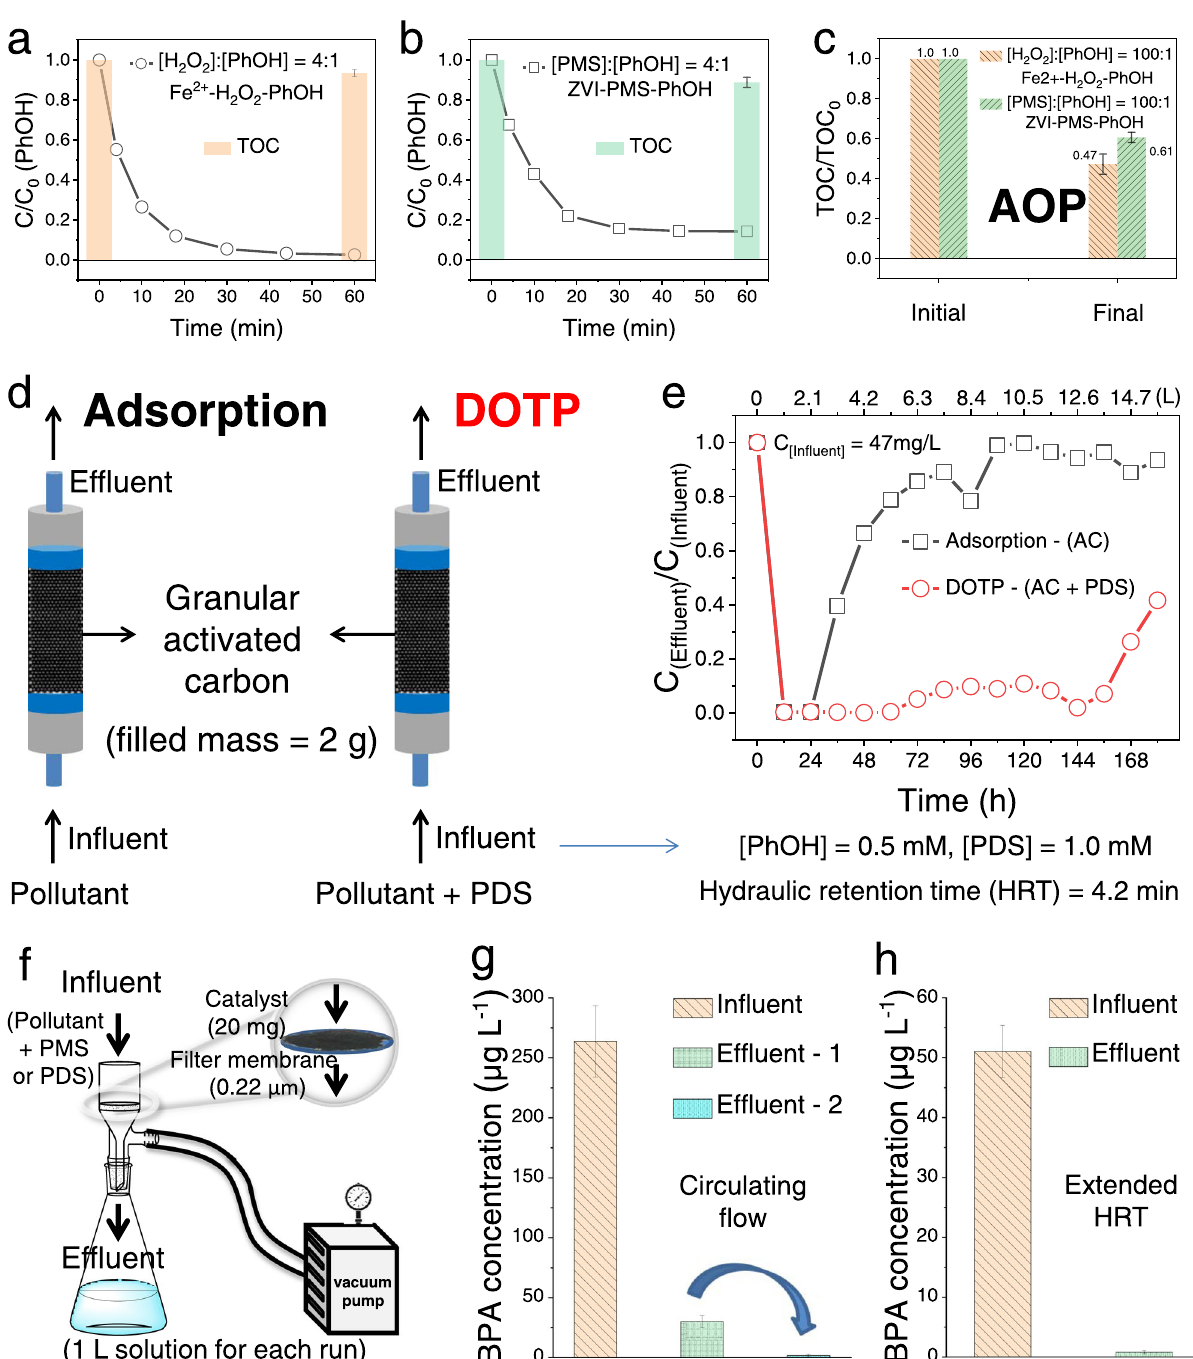
Fig. 7 Evaluation of the practical application of DOTP, AOP, and adsorption processes. a , b Pollutant removal and TOC elimination in the typical Fe 2 + / H 2 O 2 ( a ) and ZVI/PMS ( b ) AOP systems, with oxidants to pollutants dosage ratios of 4:1. c Final removal of TOC in the two typical AOP systems at an oxidant dosage 100 times the molar concentration of the pollutant. d , e Water puri fi cation effects re fl ected by the continuous- fl ow operation of DOTP and adsorption illustrated in fi xed bed reactor. f Schematic illustration of the membrane catalytic reactor (catalyst mass = 20 mg). g , h Detected BPA concentrations in the in fl uent and ef fl uent for 1-L tap water with an initial BPA concentration approximately at ( g ) 250 µ g L − 1 and ( h ) 50 µ g L − 1 . For g , the fi rst-run ef fl uent (ef fl uent-1) was re fl owed over the membrane catalytic reactor for further BPA removal to obtain the second-run ef fl uent (ef fl uent-2). For h , the hydraulic retention time (HRT) was extended from 20 min/L (in g ) to 40 min L − 1 . The circulating fl ow of the fi rst-run ef fl uent in g and the extension of HRT in h were used for increasing the contact ef fi ciencies between the pollutant/oxidant and the catalyst surface. These two methods were both effective to reduce the in fl uence of diffusion control of micropollutants at low concentrations and thus increase their removal ef fi ciency. ZVI zero-valent iron, AC activated